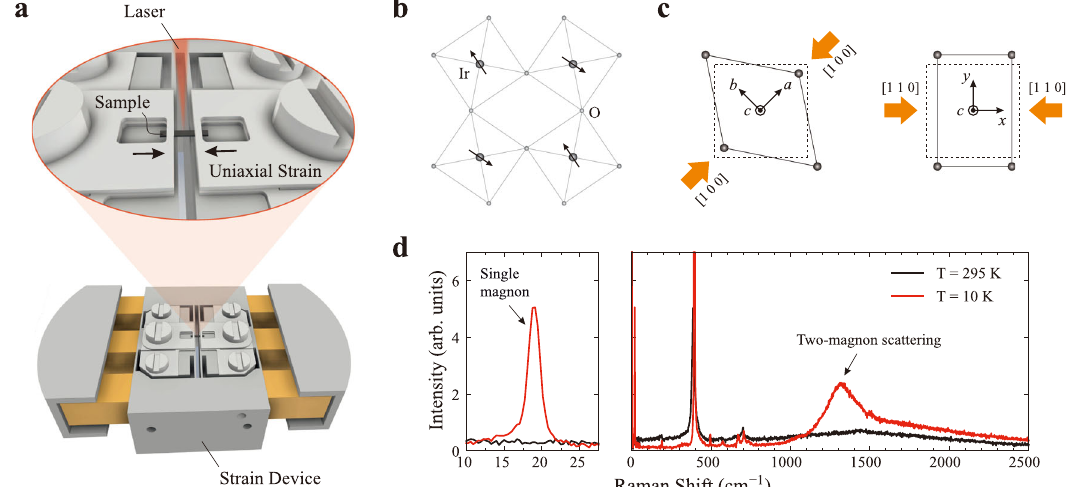
Fig. 1 | Measurement setup for uniaxialstrain experiments.a Schematicpicture of the experimental geometry with the strain device. b Sketch of the crystal and magnetic structure of an IrO 2 plane. Black (gray) circles represent Ir (O) atoms. Blackarrowsrepresentpseudospins. c Orthorhombicdeformationsof xy type(left, strain along the [1 0 0] direction) and x 2 − y 2 type (right, strain along the [1 1 0]